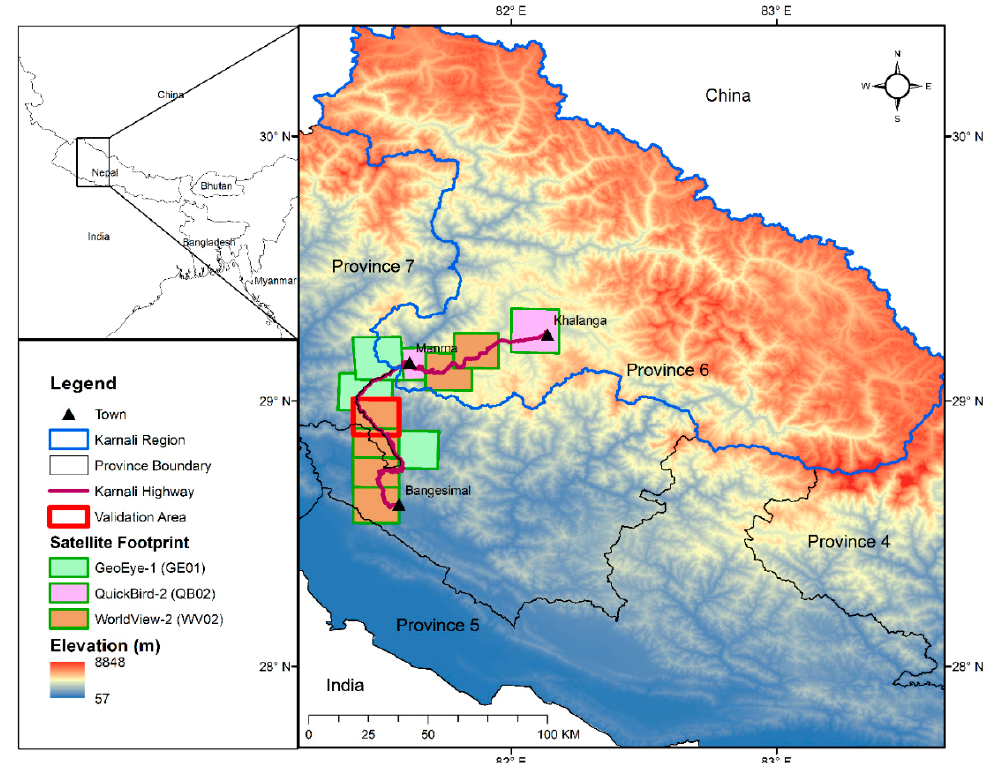
Figure 1. Study area and location of the Karnali highway. The tiles highlight the DigitalGlobe (DG) satellite footprint, with the red box indicating the validation area for the object-based image analysis (OBIA) mapping method. PlanetScope data obtained for 2018, not shown here, covers the same approximate study region as the DG satellite footprint in 22 tiles.